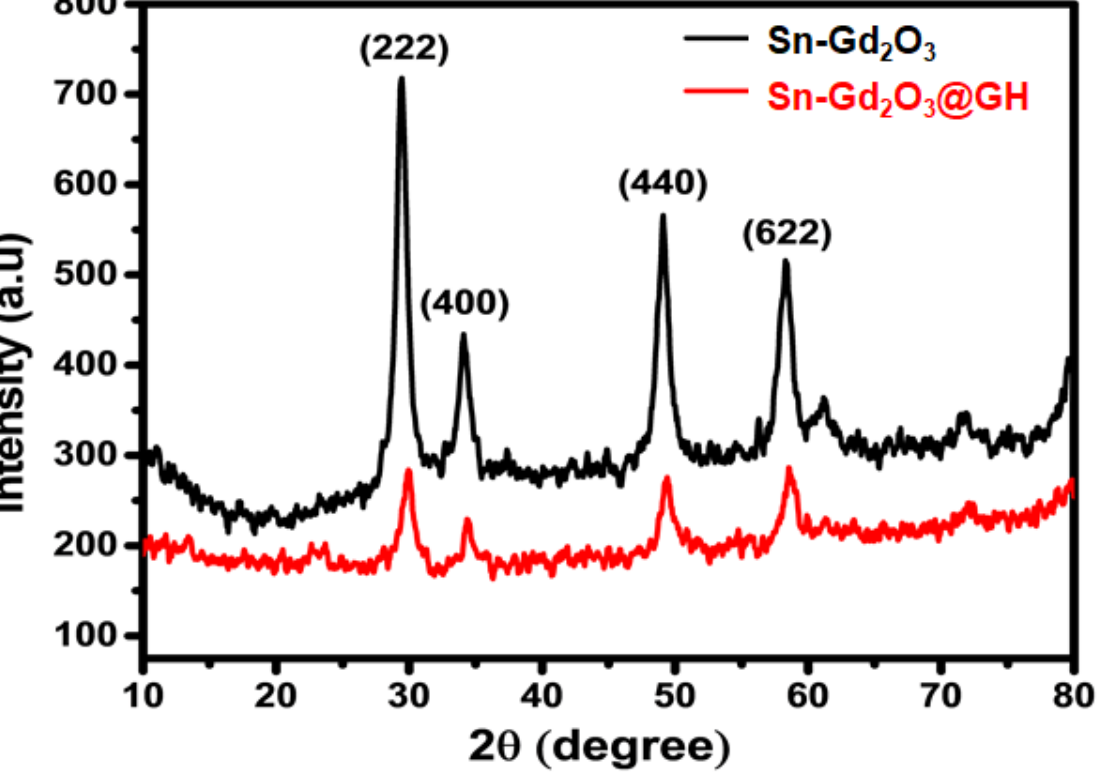
Figure 4. XRD patterns of Sn-Gd 2 O 3 nanomaterial (Black-line) and Sn-Gd 2 O 3 @GH nanocomposite (Red-line).